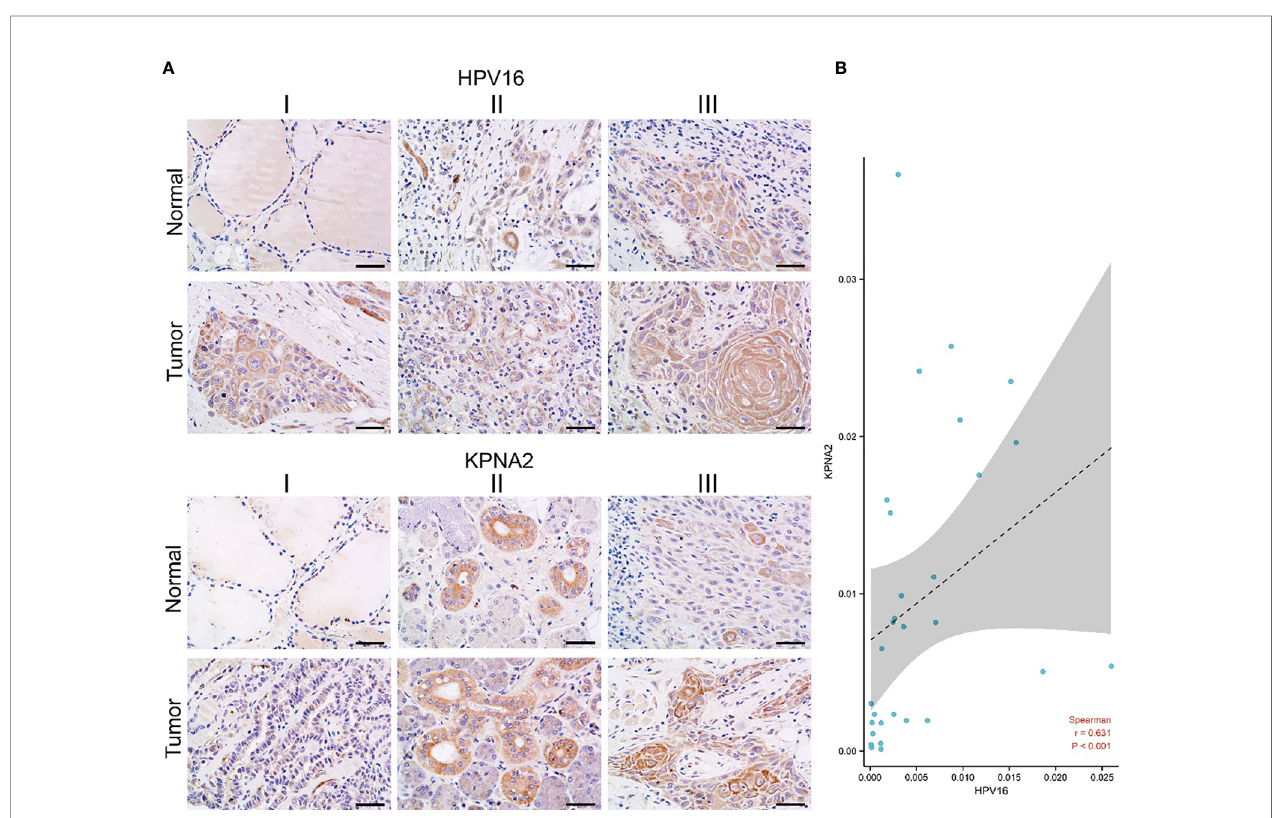
FIGURE 8 | The correlation of KPNA2 and HPV16 in TSCC patients. (A) Immunohistochemistry, (B) statistical data between KPNA2 and HPV16.